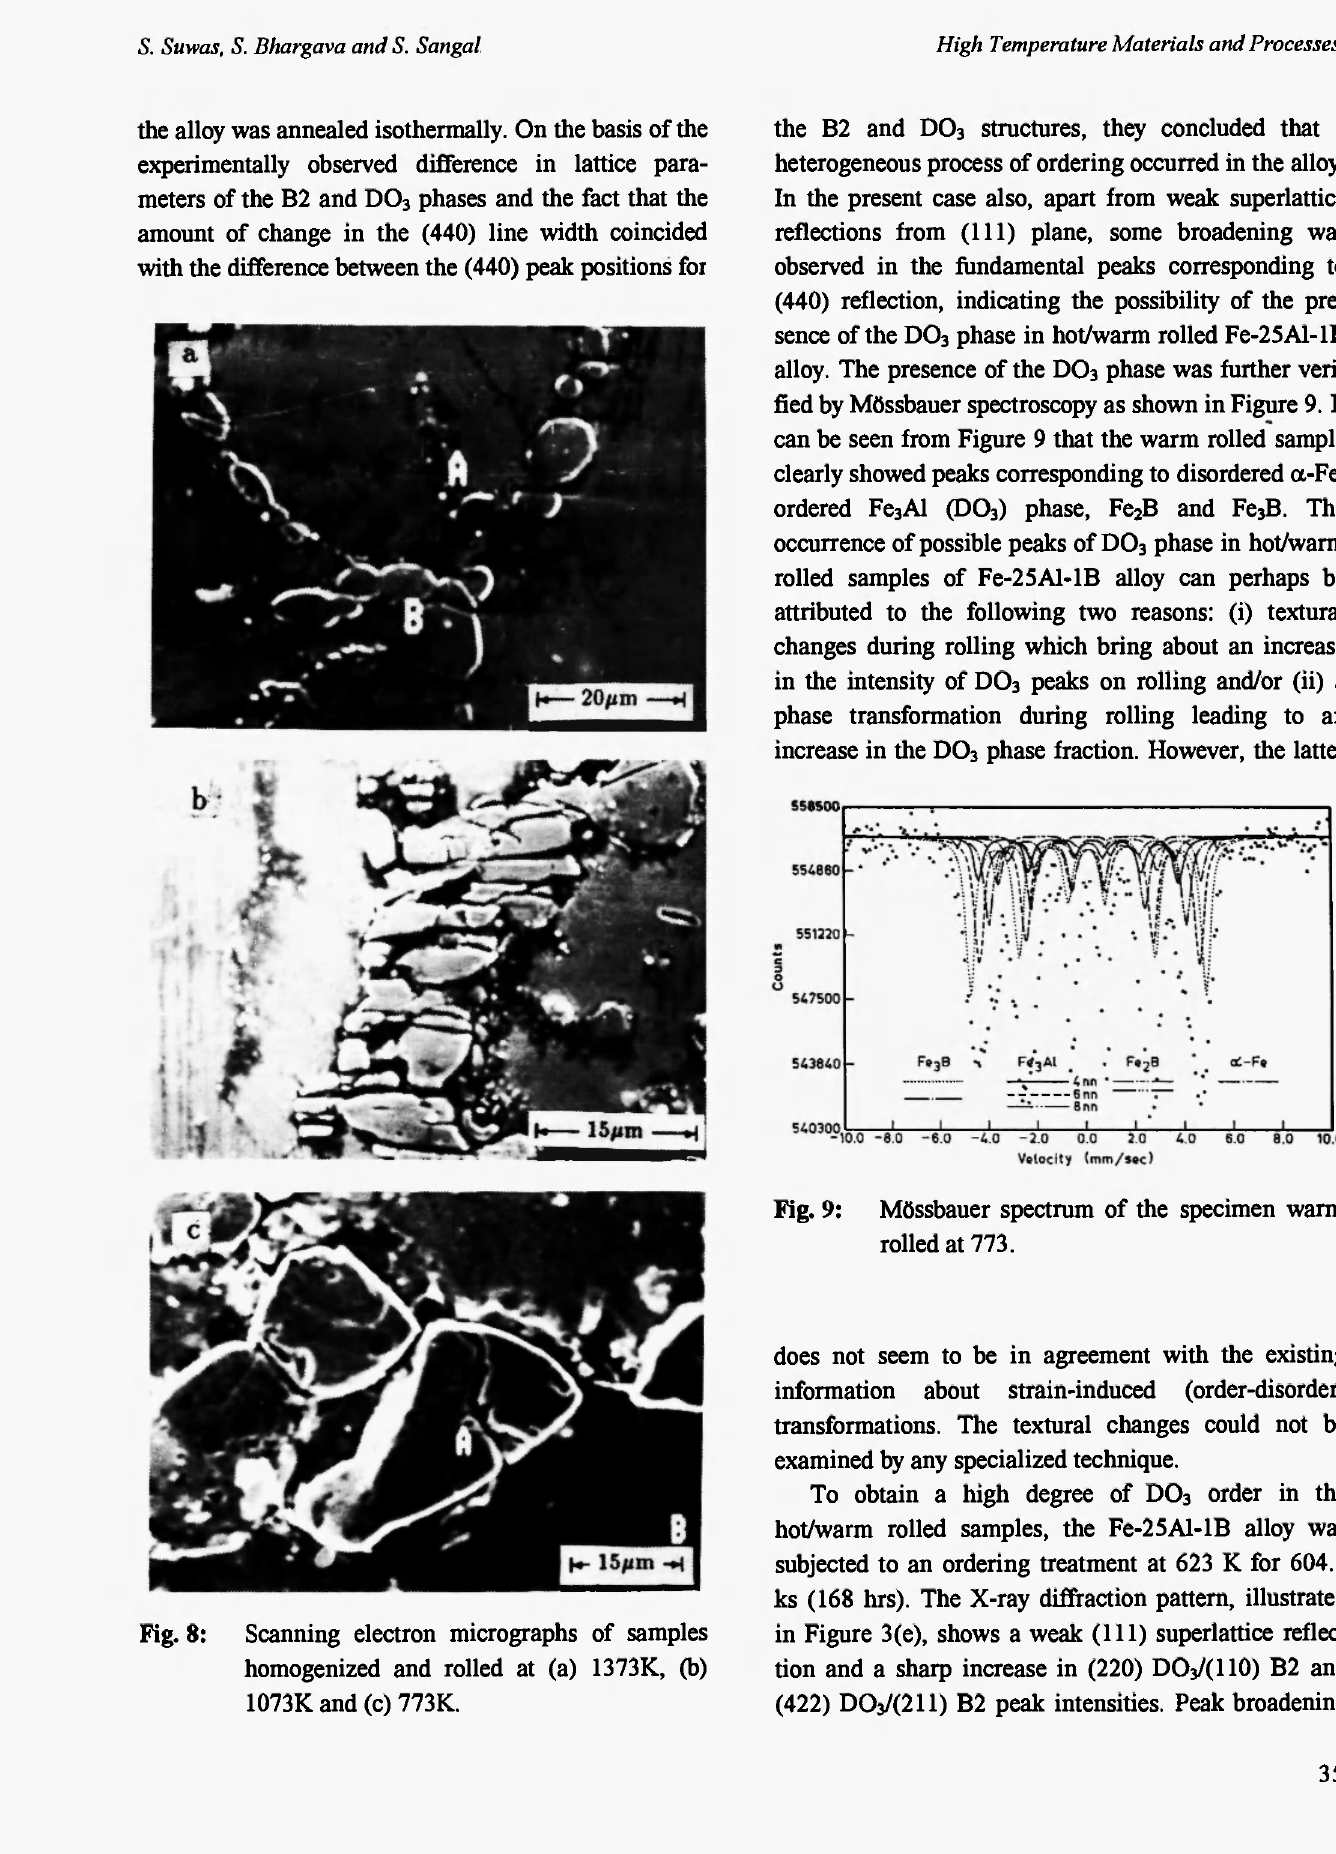
Mössbauer spectrum of the specimen warm rolled at